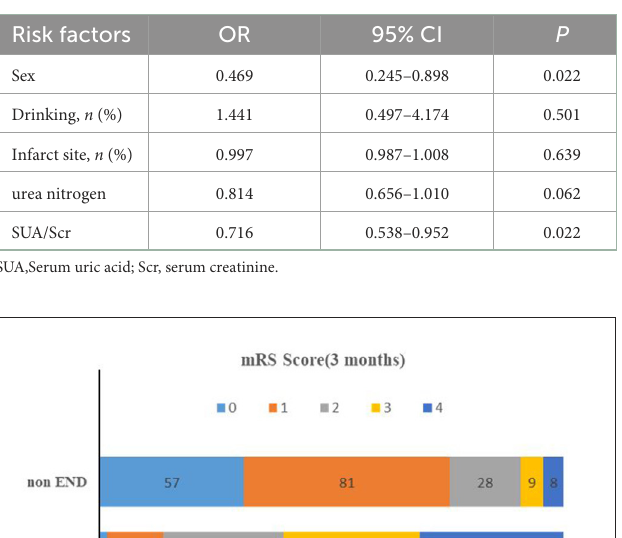
factor for neurological functional outcome only in males and